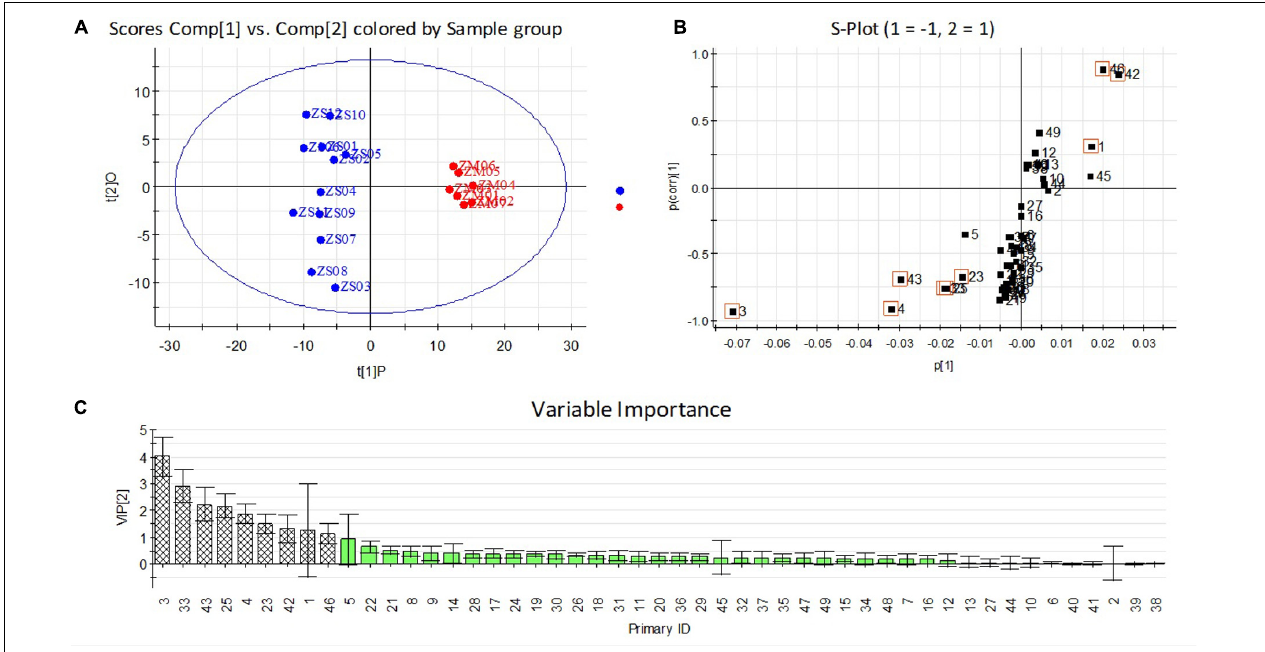
FIGURE 8 | Orthogonal projections to latent structures-discriminant analysis (OPLS-DA) (A) score plot, (B) loading S-plots and (C) variable important plots obtained from two seeds of Ziziphus species: Z. jujuba var. spinosa